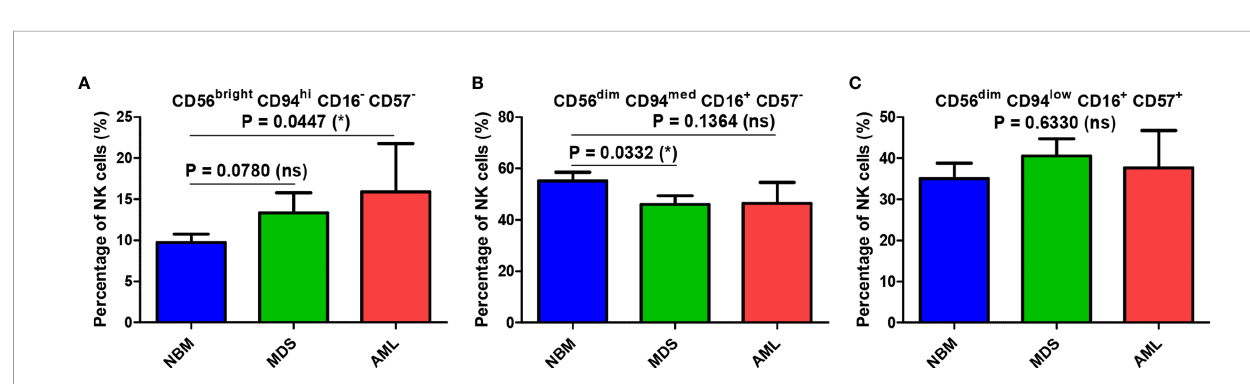
FIGURE 3 | Comparisonofcellpercentages ofdistinct NKmaturation subsets within the bone marrow microenvironment of NBM, MDS, and AML cases. (A) Percentage of bone marrow CD56 bright CD94 hi CD16 - CD57 - immature NK cells innormal bone marrow (NBM,n = 30), myelodysplasticsyndromes (MDS, n = 25), andacute myeloid leukemias (AML, n = 8) cases. Bars represent the mean ± SEM (*P < 0.05, ns, not signi fi cant; one-tailed unpaired t-test). (B) Percentage ofbone marrow CD56 dim CD94 med CD16 + CD57 - mature NK cellsinNBM (n= 30),MDS (n= 24),and AML (n = 8) cases. Bars represent the mean ± SEM (*P < 0.05, ns, not signi fi cant; one-tailed unpaired t-test). (C) Percentage of bone marrow CD56 dim CD94 low CD16 + CD57 + hypermature NK cells inNBM (n = 30),MDS (n= 25),and AML (n = 8) cases. Barsrepresent the mean ± SEM (ns, not signi fi cant; one-way ANOVA followedby Tukey ’ s MultipleComparison